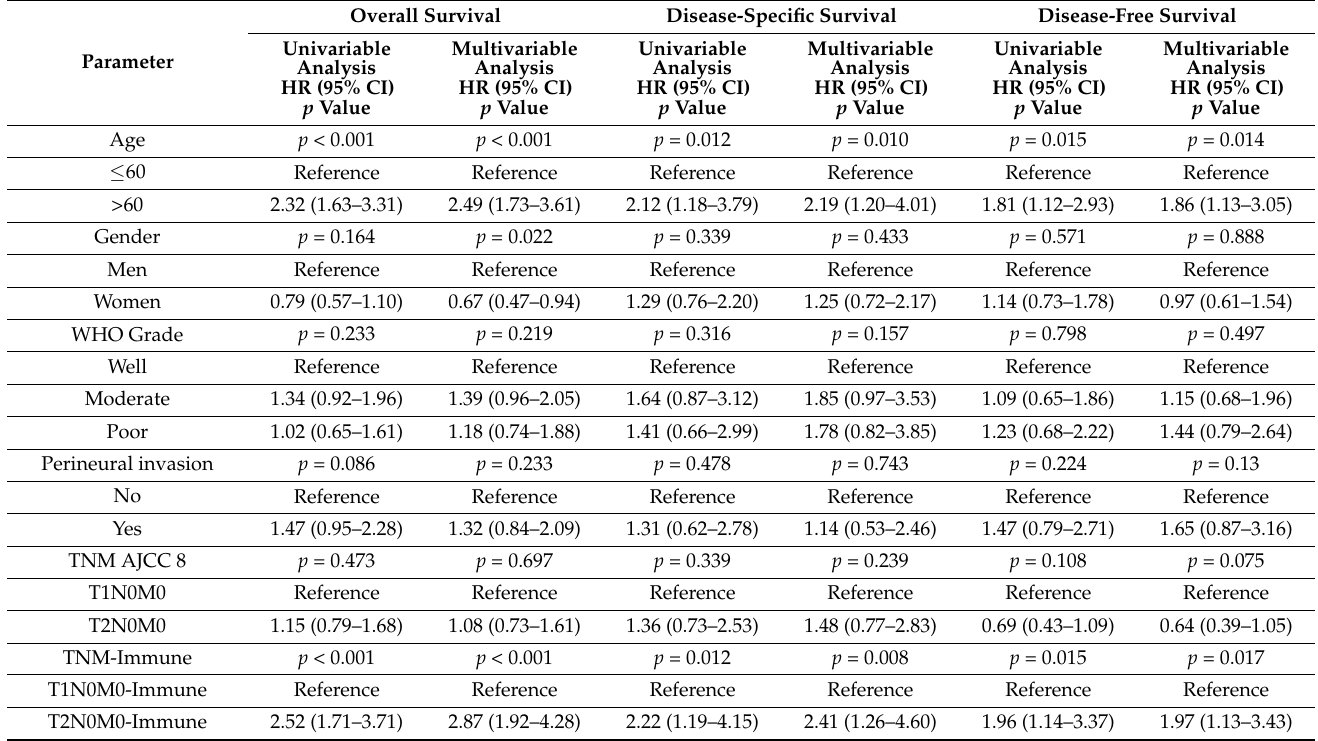
Table 2. Overall survival, disease-specific survival and disease-free survival analyses of 290 patients of early oral tongue cancer (AJCC 8). The survival analyses include the routinely evaluated classification (TNM AJCC 8 and WHO Grading) and our proposed TNM-immune